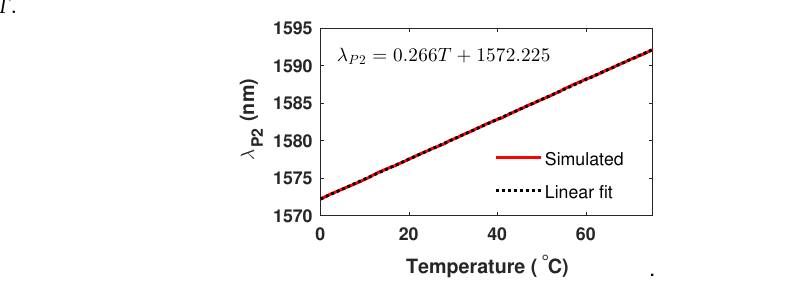
Figure 9. Wavelength position of λ P 2 as a function of T